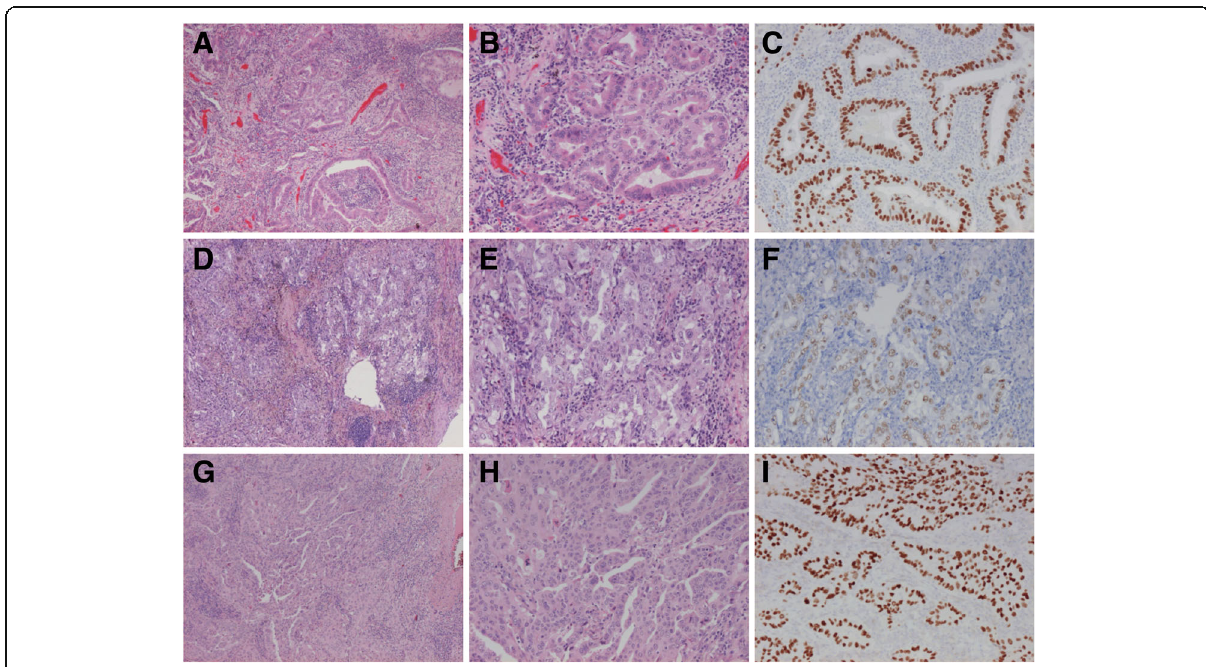
Fig. 4 Case 4. Synchronous lung adenocarcinomas in upper lobes with similar morphology but different genetic profiles. a - c The KRAS mutated tumour in the right upper lobe. a HE, x4 objective, b HE, ( c ) TTF-1. d - f The EGFR mutated tumour in the left upper lobe. d HE, x4 objective, ( e ) HE, ( e ) TTF-1 (note the weaker TTF-1 may be due to suboptimal fixation). g - i Recurrence of the tumour in the left upper lobe. g HE, x4 objective, ( h ) HE, ( i ) TTF-1. All images x10 objective unless otherwise